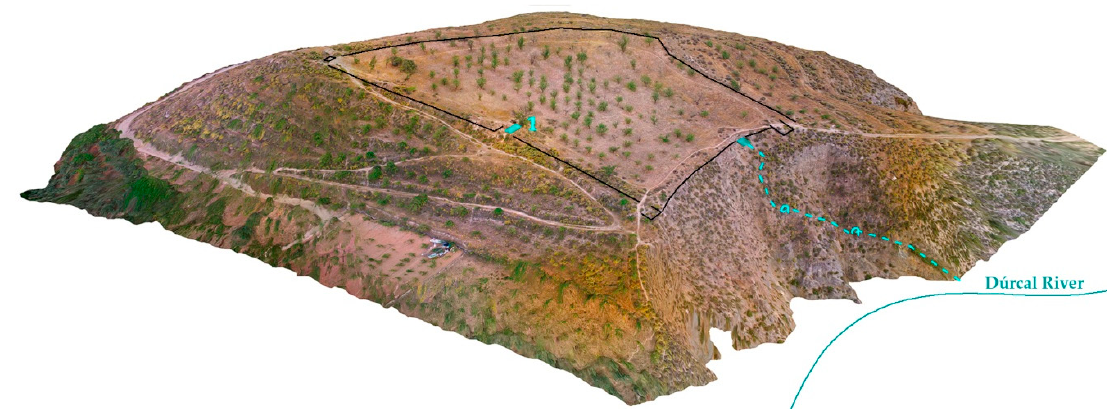
Figure 10. Photogrammetric model of the hill of the Alcazaba of Dúrcal. (1) Cistern and, in dotted lines, hypothesis of the protected passage. Created by authors.